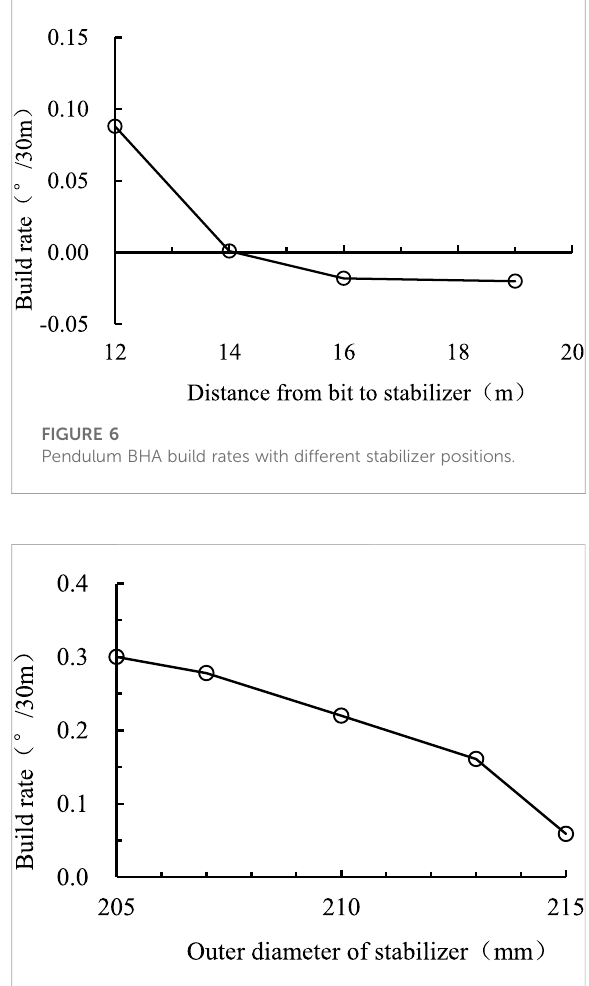
FIGURE 7 Pendulum BHA build rates with different stabilizer